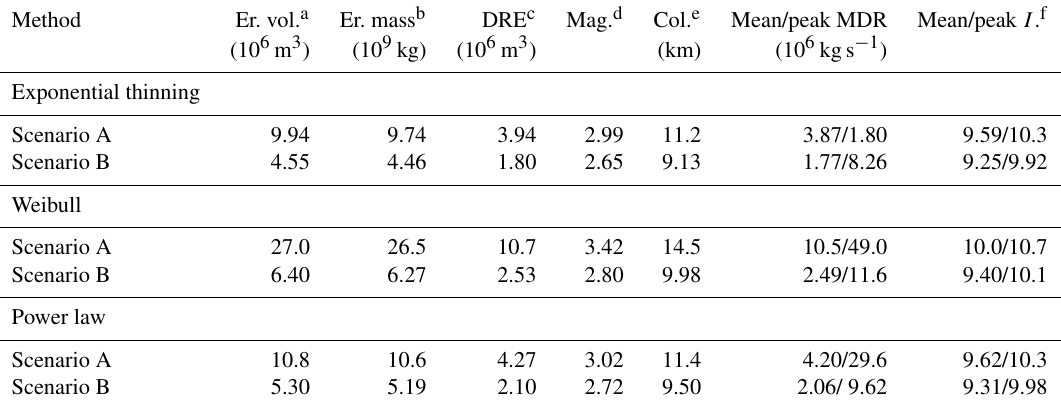
Table 1. Volume, mass and source parameters for the tephra fall deposit. See Appendix and Table A2 for details.